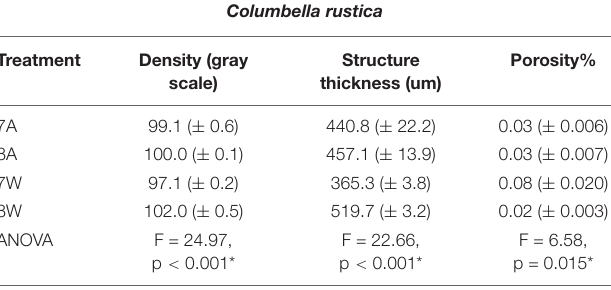
TABLE 2 | Mean density (gray scale values) of the total shell, structure thickness (um) and porosity% ( ± SE) for Columbella rustica in the four